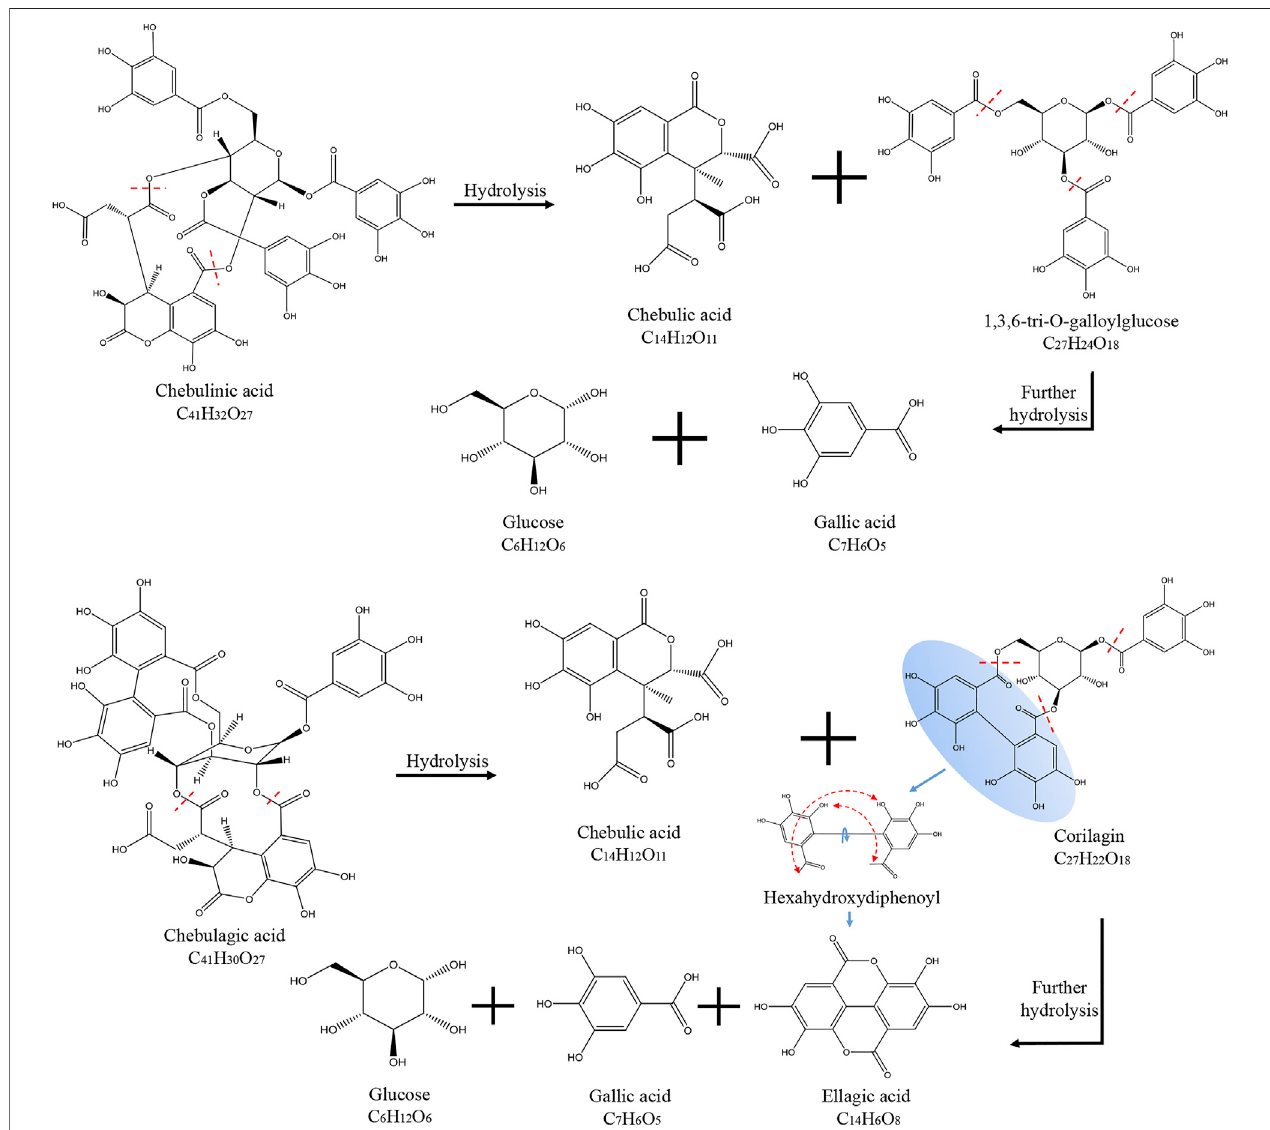
FIGURE 2 | Schematic diagram of the hydrolysis of Chebulinic acid and Chebulagic acid.